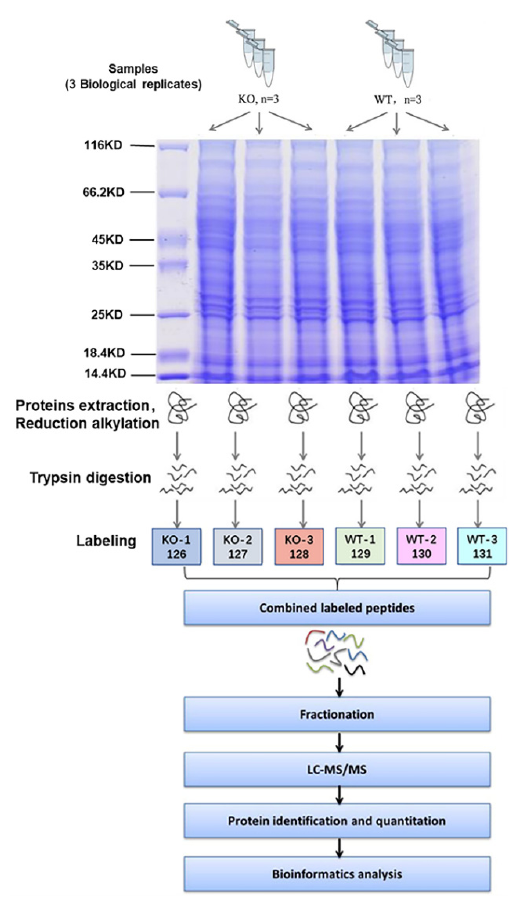
Figure 3. Flow chart of quantitative TMT proteomics experiments.